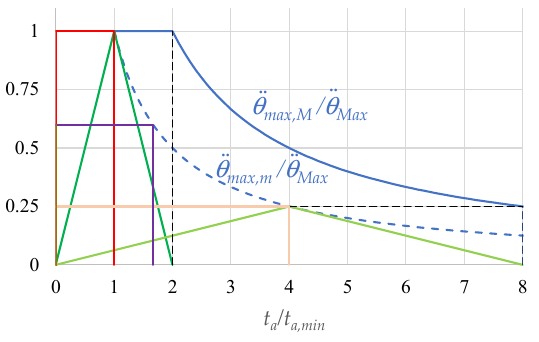
(cid:95)  t j , max versus t a / t a , min . Figure 6. Profile of t versus t t . Figure 6. Profile of j,max a a,min t , this is the minimum possible maximum acceleration that satisfies With a given a . the inequalities in Equation (25) (the violet curve in Figure 7). A rectangular acceleration It is evident that, within the range defined by the inequalities in Equation (25), there ϑ max , but whose maximum acceleration is less are also other STAPs whose area is equal to t that satisfies the inequality in Equation (30) is still char- profile with a given value of .. are also other STAPs whose area is equal to ϑ  , but whose maximum acceleration is less a ϑ Max . Nevertheless, with the same value of t j , these profiles require a greater value than max  acterized by the minimum possible maximum acceleration ϑ , given by Equation (33). t , these profiles require a greater value than ϑ  . Nevertheless, with the same value of max,m j Max .. t of ϑ max , m is profiles ( t j is equal to zero), whose maximum acceleration a t . a .. ϑ max , m = t equal to 2 t , the a a,min t greater than 2 light green curve is a triangular acceleration profile with t , the red a a,min t equal to t , and the pink rectangle has an a a,min acceleration time that is half that of the light green one. The violet rectangle is character- t less than 2 . ized by a value of t and therefore does not reach ϑ  .. a a,min Max ϑ max , m , given by Equation (33). the minimum possible maximum acceleration